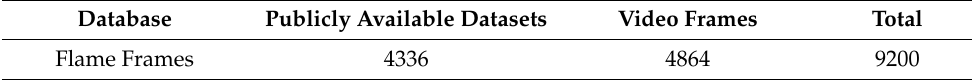
Table 1. Separation of flame images in the database. Database Publicly Available Datasets Video Frames Total Flame Frames 4336 4864